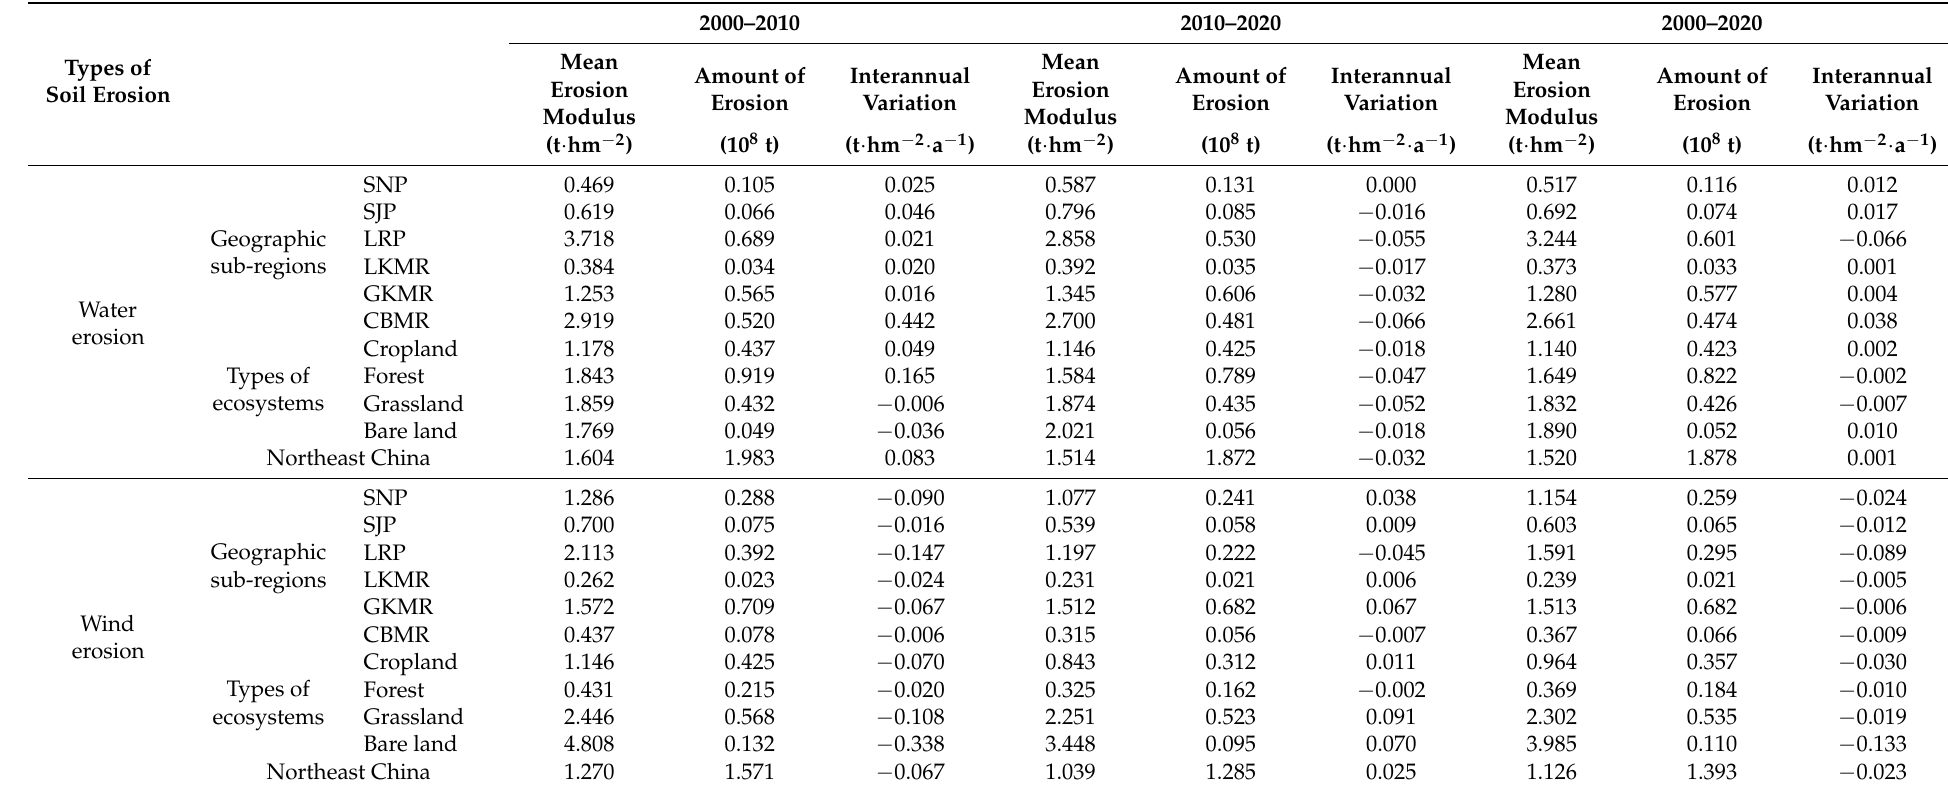
Table 2. Water and wind erosion in Northeast China from 2000 to 2020, displayed in different